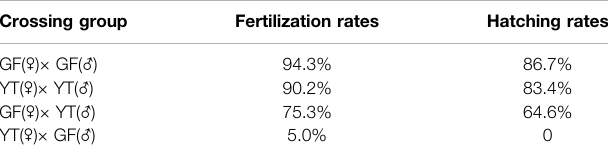
TABLE 2 | Fertilization rates and hatching rates of different crosses.